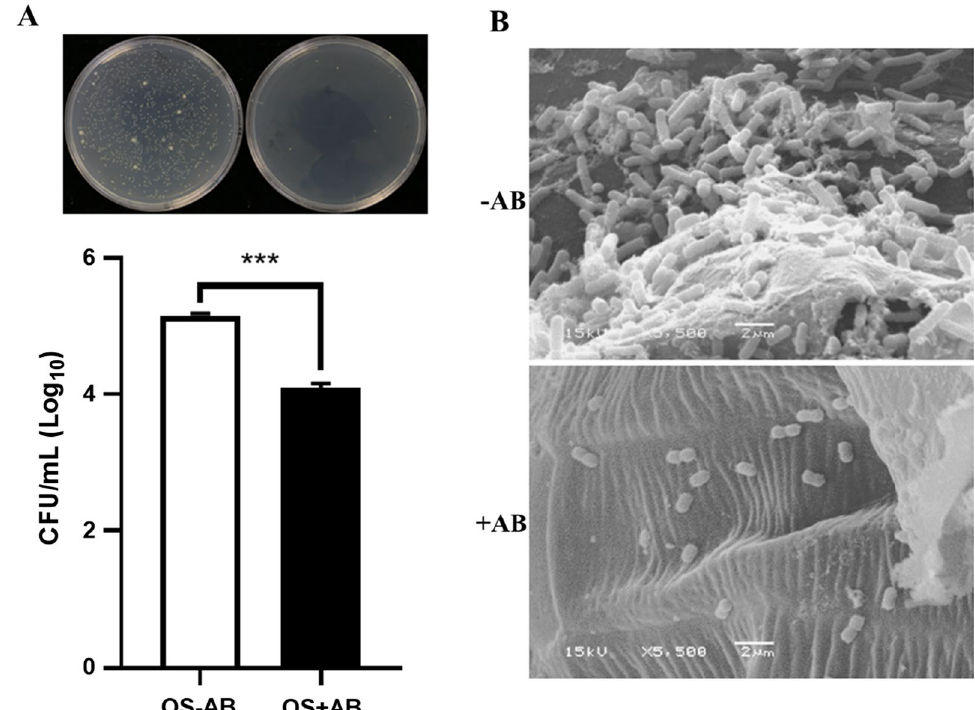
Fig. 2 Field-collected Chilo suppressalis (SSB) larvae with AB treatment orally secreted lower quantities of bacteria onto the rice stems around the larval feeding area. A Comparison of bacteria quantities in the oral secretion (OS) of field-collected SSB larvae with 2 days of feeding on artificial diets with or without AB. Values are log 10 transformed means SEM (n 5), and asterisks indicate significant differences between treatments ± = (Unpaired t -test; t 14.88, df 8, P < 0.001). B Scanning electron microscopy images of bacteria secreted onto rice stems during 1 h of feeding by = = SSB larvae with or without AB treatment (Scale bar